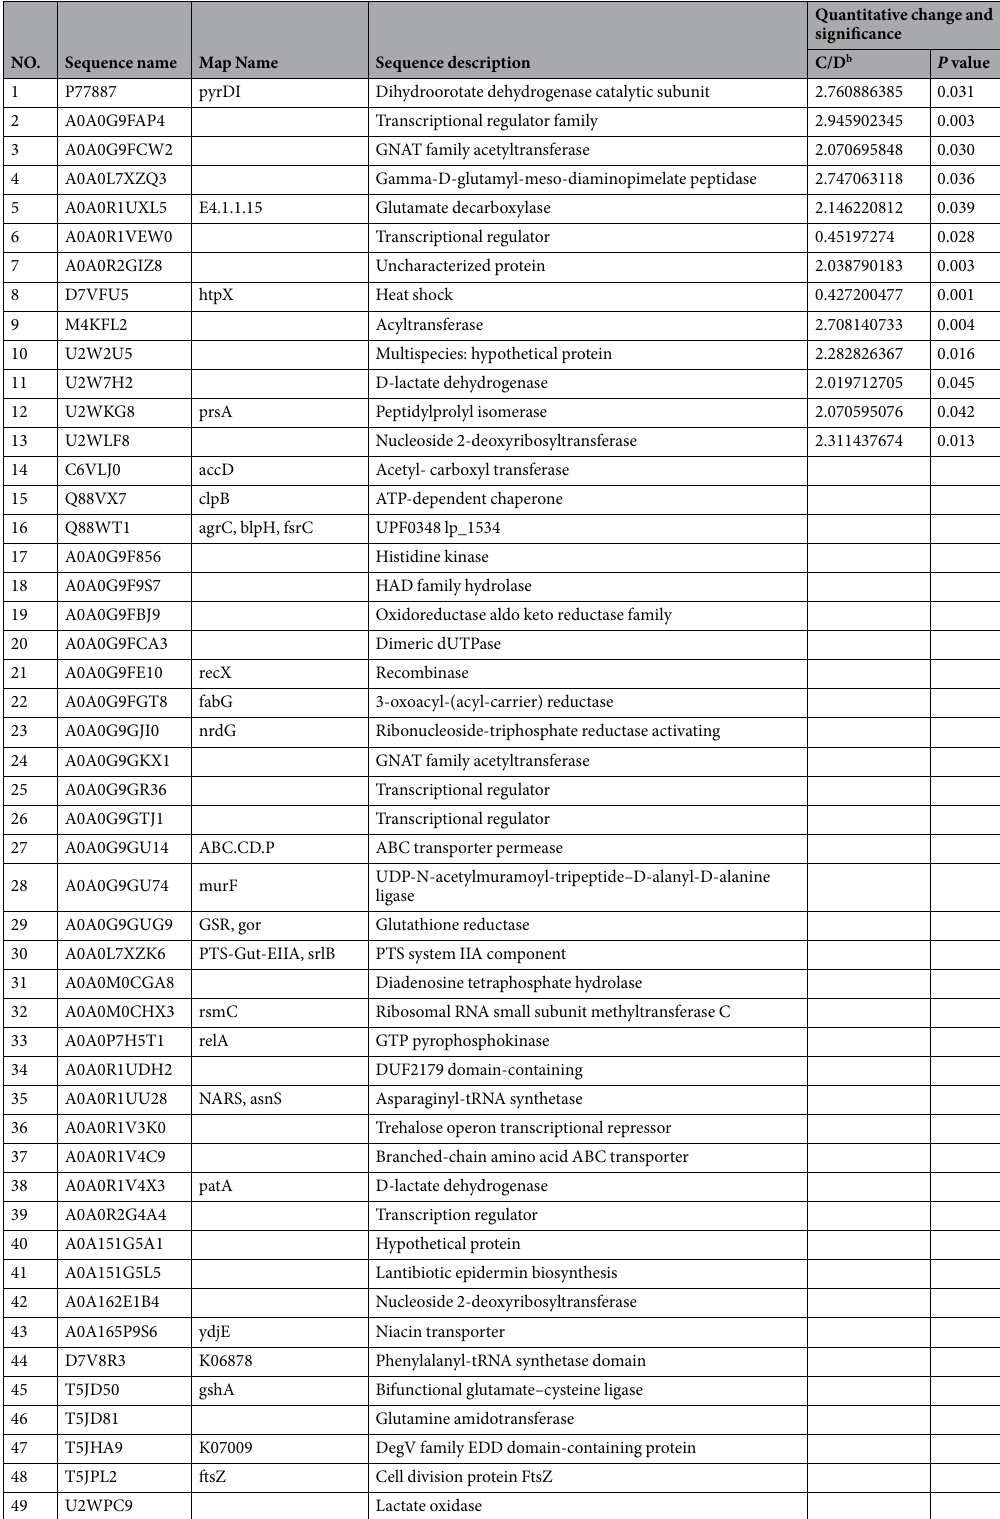
Table 2. Differentially expressed proteins between the luxS mutant and the wild-type strain in co-cultivation with L. helveticus KLDS1.9207. b C: Co-cultivation of the luxS mutant strain with L. helveticus KLDS1.9207; D: Co-cultivation of the wild-type strain with L. helveticus